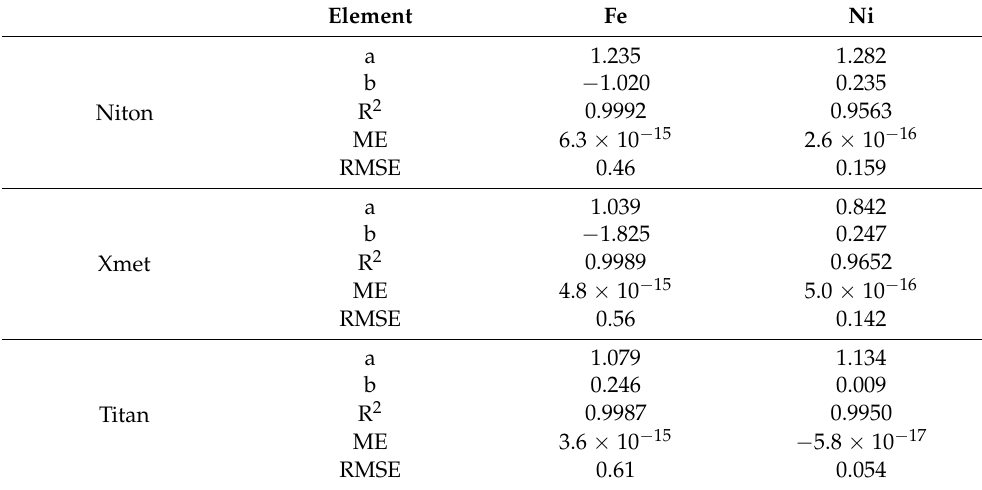
Table 3. Parameters of the simple regression for the two elements and for the three devices (a: Slope, b: y-intercept, R 2 : Coefficient of determination, ME: Mean error, RMSE: Root-mean-square error). Element Fe Ni a Niton